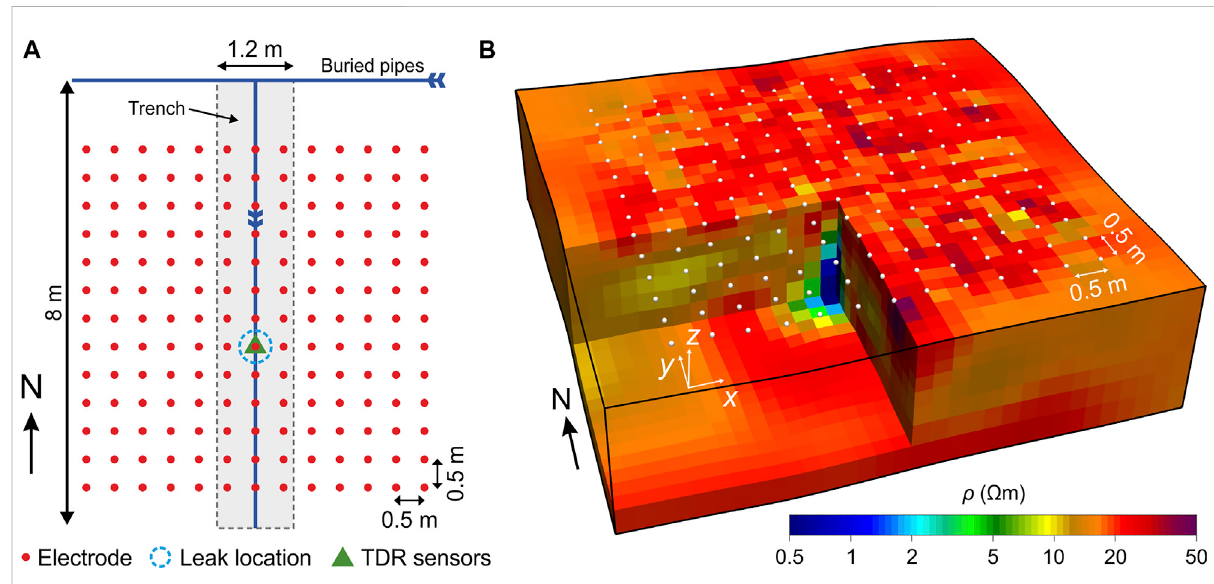
FIGURE 11 (A) Array of 13 × 13 electrodes (red dots) used to monitor the simulated leak from utility pipe buried at 0.7 m depth. Light grey region indicates locationoftrench,bluedottedlinesshowleaklocation,andgreentriangleindicatespositionofverticalarrayofTDRsensors. (B) Invertedresistivity, ρ , image of the ERT and TDR monitoring trench at Site 3 showing electrode locations (white dots). A strong conductive anomaly is present coincident with the locations of the TDR probes.